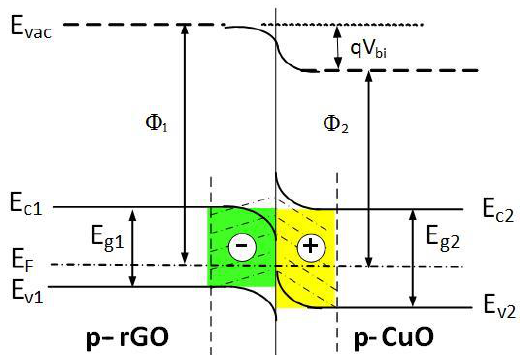
Figure 14. Isotype p-rGO / p-CuO heterojunction with a hole accumulation layer on the CuO side and a hole depletion layer on the rGO side. Φ 1 and Φ 2 are work functions of the junction partners, V bi is the built-in potential.